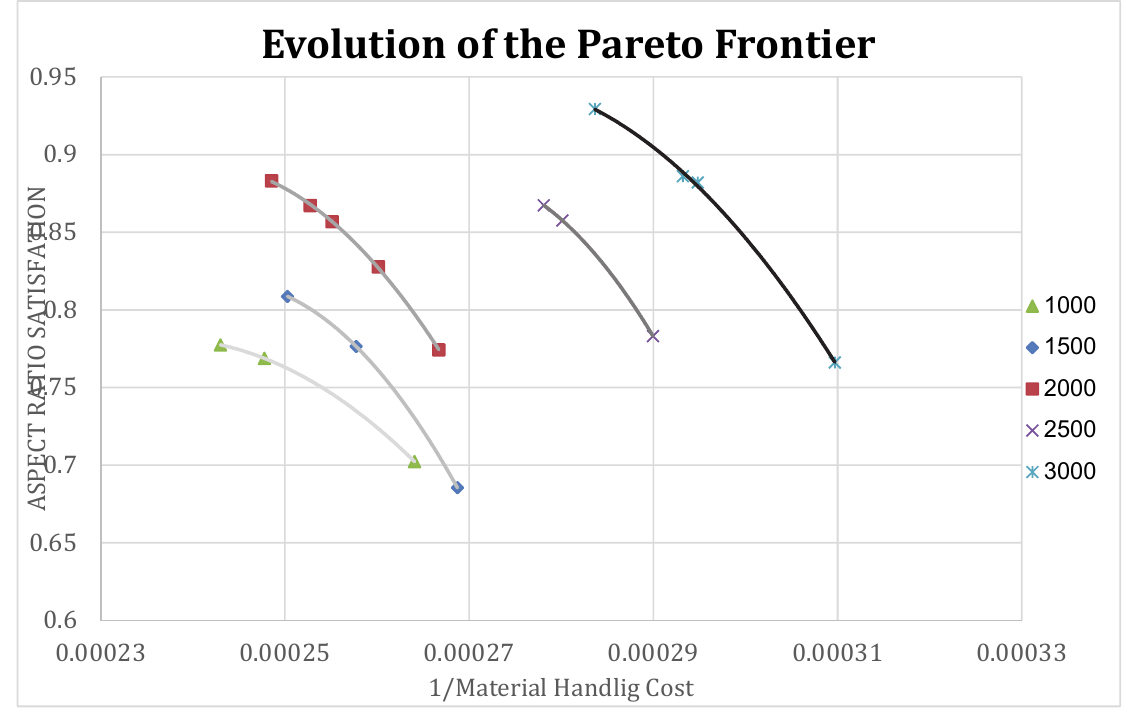
Fig. 5. Evolution progress of the Pareto